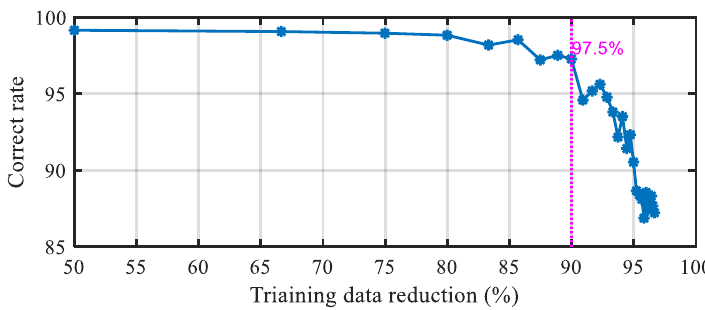
ff ects of di ff erent proportions of training data on classification Figure 10. Effects of different proportions of training data on classification accuracy. Figure 10. E